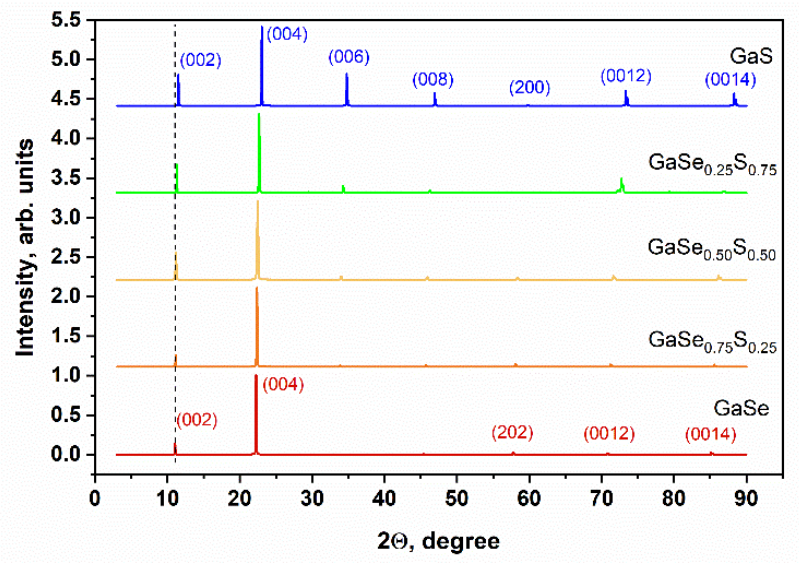
Figure 2. X-ray diffraction (XRD) patterns of the as-grown GaSe 1 − x S x crystals. Figure 3a represents the Raman spectra of GaSe 1 − x S x crystals. The Raman spectrum of the exfoliated GaSe flakes has three typical peaks at 134, 212, and 307 cm − 1 , which correspond to the A 1 g1 , E 2g, and A 1 g2 vibrational modes, respectively. In the case of GaS, the Raman spectrum also shows the three dominant peaks at 188, 294, and 359 cm − 1 corresponding to the same vibrational modes. Modes A 1 g1 and A 1 g2 refer to the compres- sion/stretching out-of-plane vibrations of atoms, and E 2g corresponds to shear modes of in-plane vibrations. The ternary GaSe 1 − x S x crystals demonstrate Raman peaks that shifted proportionally to the sulfur content and can be considered as a superposition of the corresponding GaSe and GaS Raman bands. Thus, according to the structure of ternary alloys, the three-component GaSe 0 . 50 S 0 . 50 crystal demonstrates the two main peaks cor- responding approximately to the average value of the Raman bands of GaSe and GaS: (134 + 188)/2 = 161 (calculated) versus 169 cm − 1 experimental and (307 + 360)/2 = 333.5 (calculated) versus 340 cm − 1 experimental. The observed discrepancy between the exper- imental and the calculated average values may indicate a slight predominance of sulfur or selenium concentration in the GaSe 1 − x S x composition. At the same time, the first peak at 135 cm − 1 in the case of GaSe 0.50 S 0.50 crystal indicates the presence of the initial GaSe structure, while the peak at 156 cm − 1 can be attributed to Ga 2 Se 3 , which can appear as a transition phase due to the doping process, and/or to elemental sulfur with a typical Raman peak at 153–154 cm − 1 , which can be partly intercalated between GaSeS layers. It is assumed that the peak at 216 cm − 1 represents a slight deformation of the initial GaSe structure which leads to a shift of E 2g mode to 212 cm − 1 , and this peak disappears with a further increase in the sulfur content.